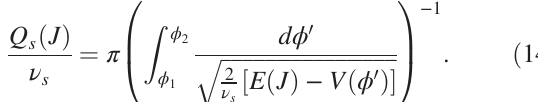
ffiffiffiffiffiffiffiffiffiffiffiffiffiffiffiffiffiffiffiffiffiffiffiffiffiffiffi p 1 − sin 2 ϕ ffiffiffiffiffiffiffiffiffiffiffiffi p 1 − r 2